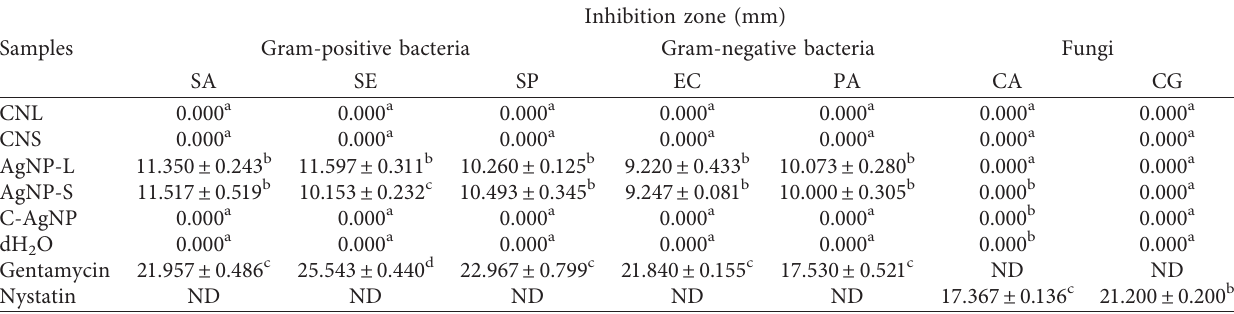
Table 1: Inhibition zones (mm) of the biosynthesised silver nanoparticles against microorganisms using the disc diffusion method (mean ± SD, n � 3); mean values are significantly different ( p < 0.05) between tested samples in each particular bacterium/fungus with different lower case superscript letters a, b, c, and d.